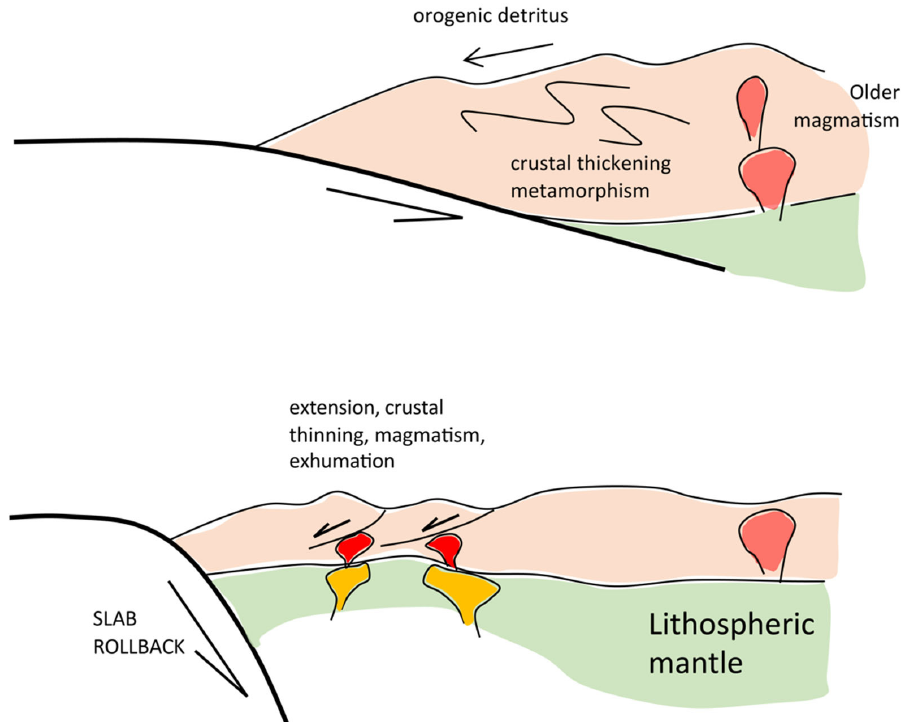
Figure 14. Schematic tectonic model for the Queen Maud Mountain–south Victoria Land sector of the paleo-Pacific margin of Gondwana. The upper figure broadly corresponds to the earlier time (~late Neoproterozoic-early Cambrian) of crustal thickening indicated in Figure 13, whereas the lower figure corresponds to the later time (~Cambrian) of crustal thinning, possibly due to extension related to slab rollback.